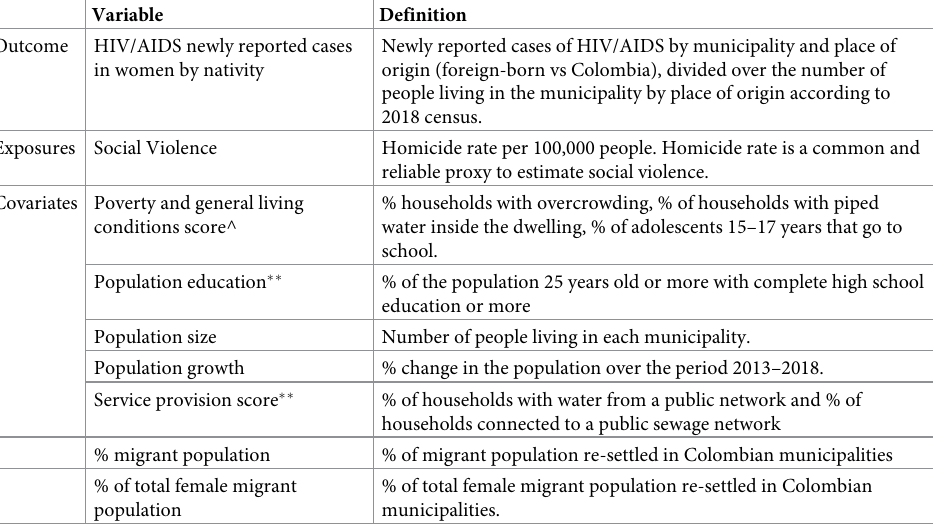
Table 1. Main outcome &